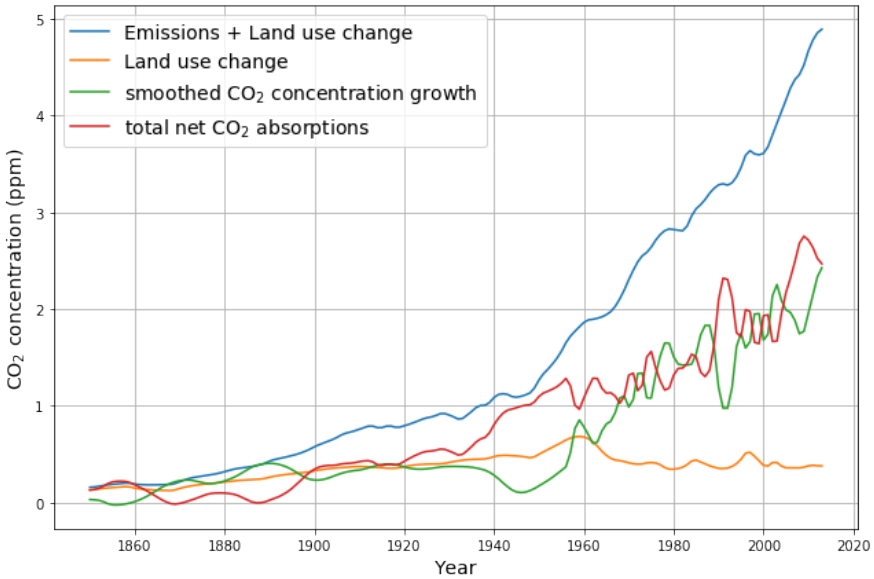
Figure 1. Emissions, land use change, and CO 2 concentration